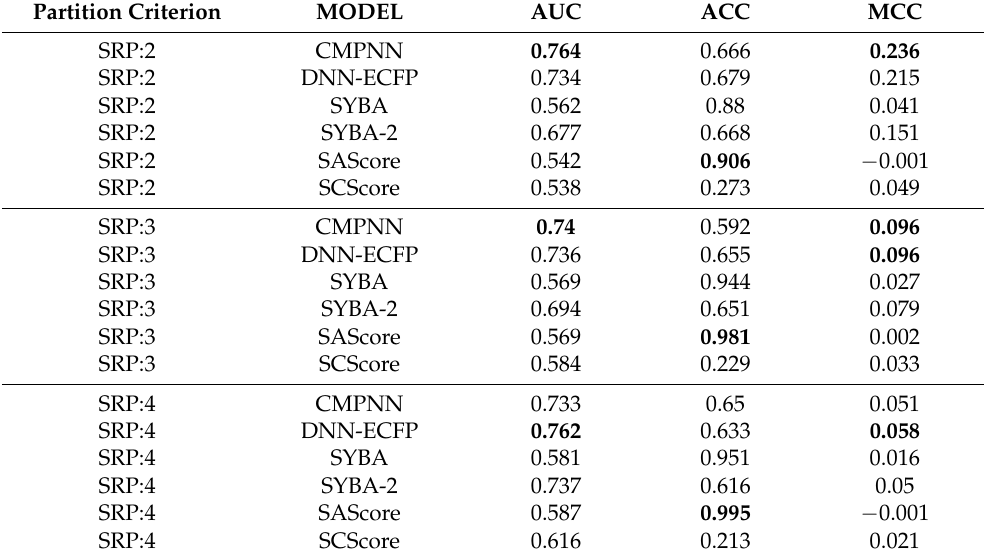
Table 4. The performance of different models on an unbalanced test set.